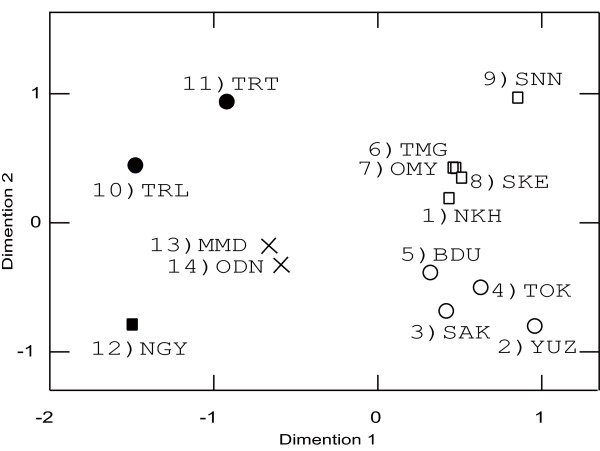
Multidimensional scaling analysis of Platypus quercivorus based on Nei et al.'s distances DA [35]. SAMOVA [39] when K = 5 is shown using different plot markers which correspond to the NJ tree in Fig 4.